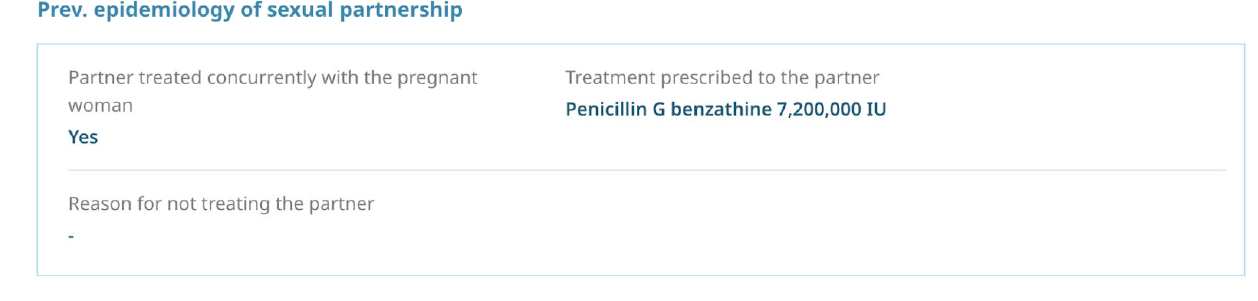
Figure A6. Pregnant epidemiological background.